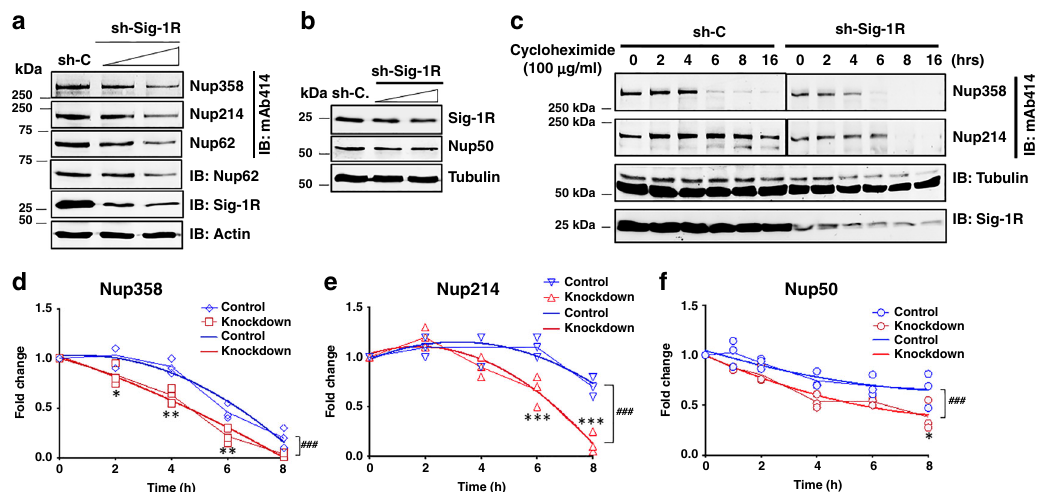
Fig. 3 Sig-1R regulates nuclear pore protein stability. a Knockdown of sigma-1 receptor (Sig-1R) by shRNA (shSig-1R) dose-dependently caused a reduction of nucleoporins (Nups). HeLa cells were transiently transfected with either shRNA control (sh-C) or different doses of shSig1R vector. Forty-eight hours after transfection, western blot was performed to detect protein expression levels of Sig-1R, Actin, and Nups. In the western blot, Nup62 was probed by mAb414 or a speci fi c Nup62 antibody. b Sig-1R knockdown dose-dependently reduced the level of Nup50. c Faster turnover of Nup358 or Nup214 in Sig-1R knockdown cells. Cycloheximide (100 µ g/ml) was added to stop de novo synthesis of proteins. Time-lapsed levels of Nups were examined by western blot probed by mAb414. d – f Summarized results from three sets of independent turnover studies on Nup358, Nup214, and Nup50. Data were subjected to two-way ANOVA followed by Sidak ’ s multiple comparisons test (Graphpad Prism version 8.2). For d Nup358, p values are 0.022, 0.001, 0.0045, and 0.0801 for 2 h, 4 h, 6 h, and 8 h, respectively; for e Nup214, p values are 0.7858, 0.1538, 0.0004, and <0.0001 for 2 h, 4 h, 6 h, and 8 h, respectively; For f Nup50, p values are 0.2869, 0.583, 0.0602, 0.2899, and 0.0074 for 1 h, 2 h, 4 h, 6 h, and 8 h, respectively. * p < 0.05; ** p < 0.01; *** p < 0.001. Data were also subjected to non-linear regression for best fi t. For d Nup358, F (3,24) value: 11.47; for e Nup214, F (3, 24) value: 20.21; for f Nup50,